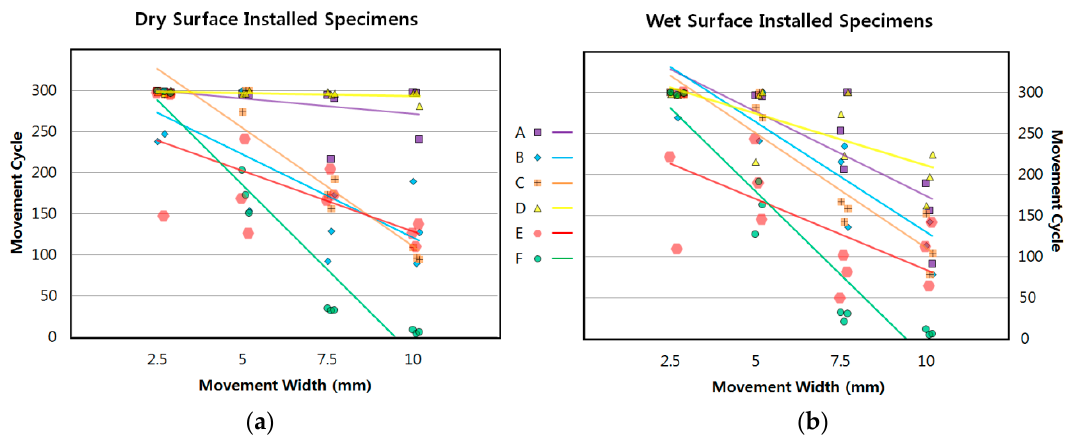
Figure 10. Comparison of specimen movement cycle leakage on dry and wet surface specimens; ( a ) estimated performance trends of dry surface installed specimens; ( b ) estimated performance trends of wet surface installed specimens